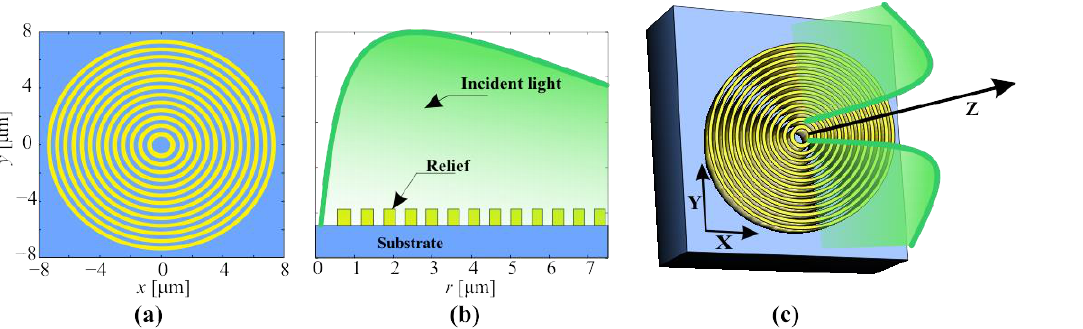
Figure 1. The template of BZP in transverse ( a ), longitudinal ( b ) planes and in 3D projection ( c ) illuminated by incident light (schematic representation). Table 1. Radii of BZP’s zones .